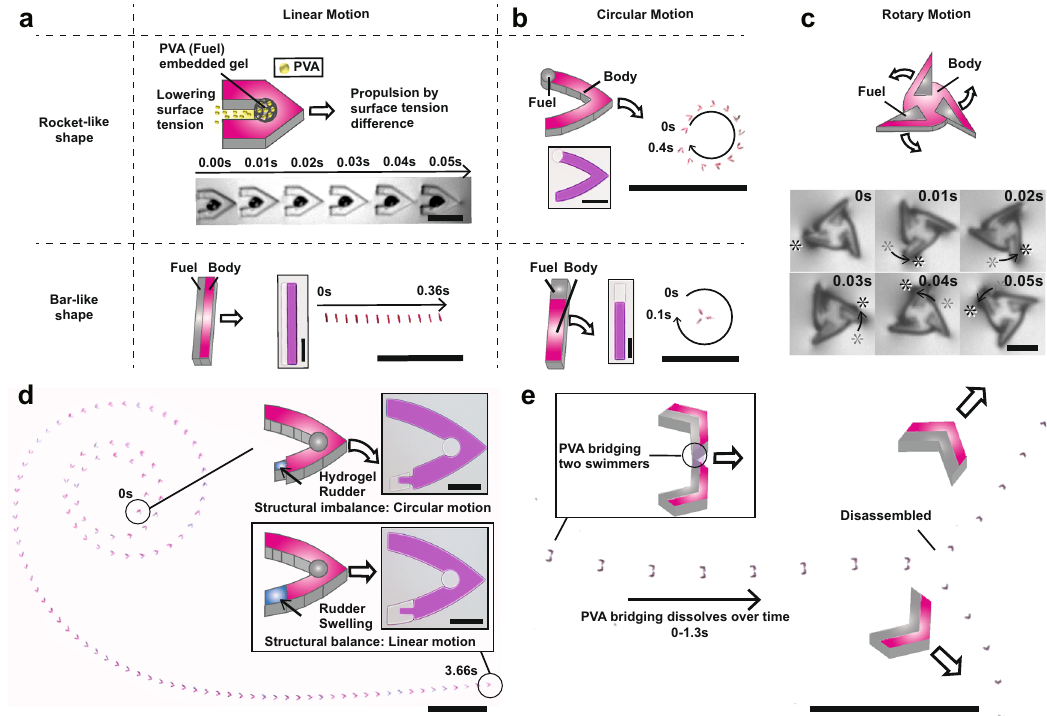
Fig. 1 Schematic of Marangoni microswimmers with multifunctional parts for highly programmable motion. a PVA released from the fuel part lowers the surface tension of the adjacent areas and enables propulsion through the Marangoni effect. The hydrophobic body (red) enables swimmers to fl oat on the surface of the solution. Middle (in black and white): FastCam images of a microswimmer with linear motion; scale bars represent 250 µ m (black box and FastCam images) and 1 cm (zoom-out pictures). b Circular motion of swimmers enabled by selectively designing balance of the swimmer structure and surface tension pro fi le; scale bars represent 250 µ m (black boxes) and 1 cm (zoom-out pictures). c Rotary motion of the microswimmer. The asterisk marks the same wing of the microswimmer; the scale bar represents 100 μ m. d Time-course motion change of the microswimmer. The size of the hydrogel rudder placed on the microswimmer changes due to swelling, which leads to a change in their motion from circular to linear. The volume ratio of PEGDA:Ethanol for the porous hydrogel rudder fabrication is 5:5; scale bar represents 250 µ m (black boxes) and 1 cm (zoom-out pictures). e By bridging two swimmers with water-soluble PVA, swimmers are disassembled after a designated time. Scale bar represents 1